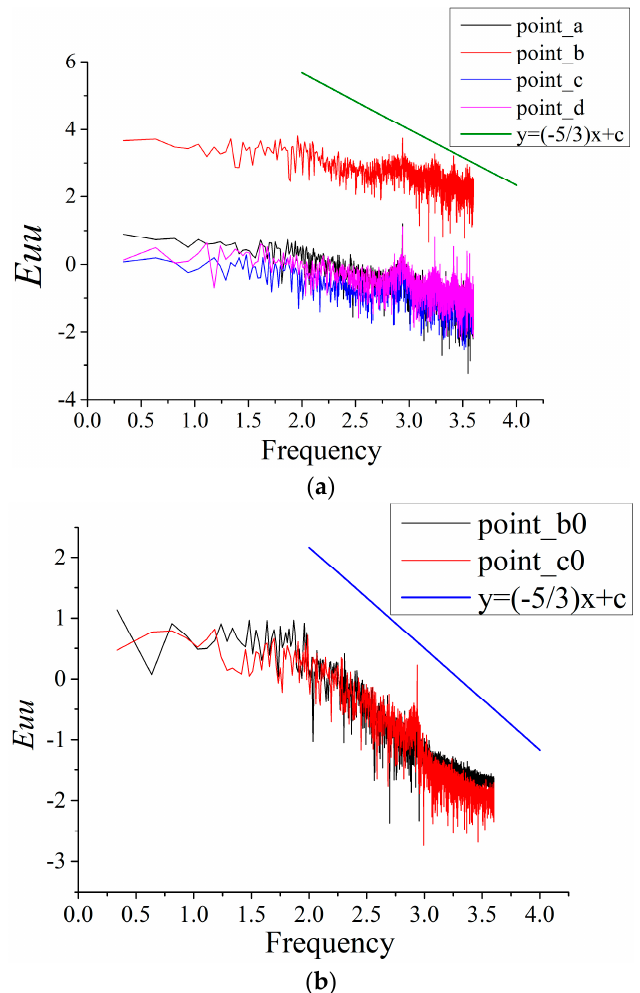
Figure 26. Kinetic energy spectrum of monitoring points on the Z = 0 m plane. (a) at point a, b, c, and d, (b) at point b0 and c0